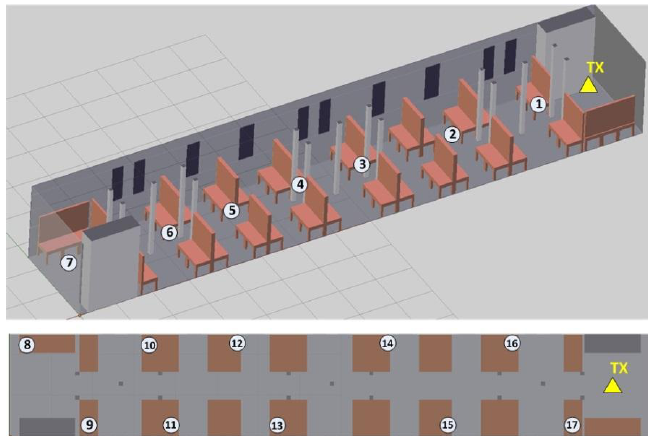
Figure 13. Measurement points within the passenger wagon